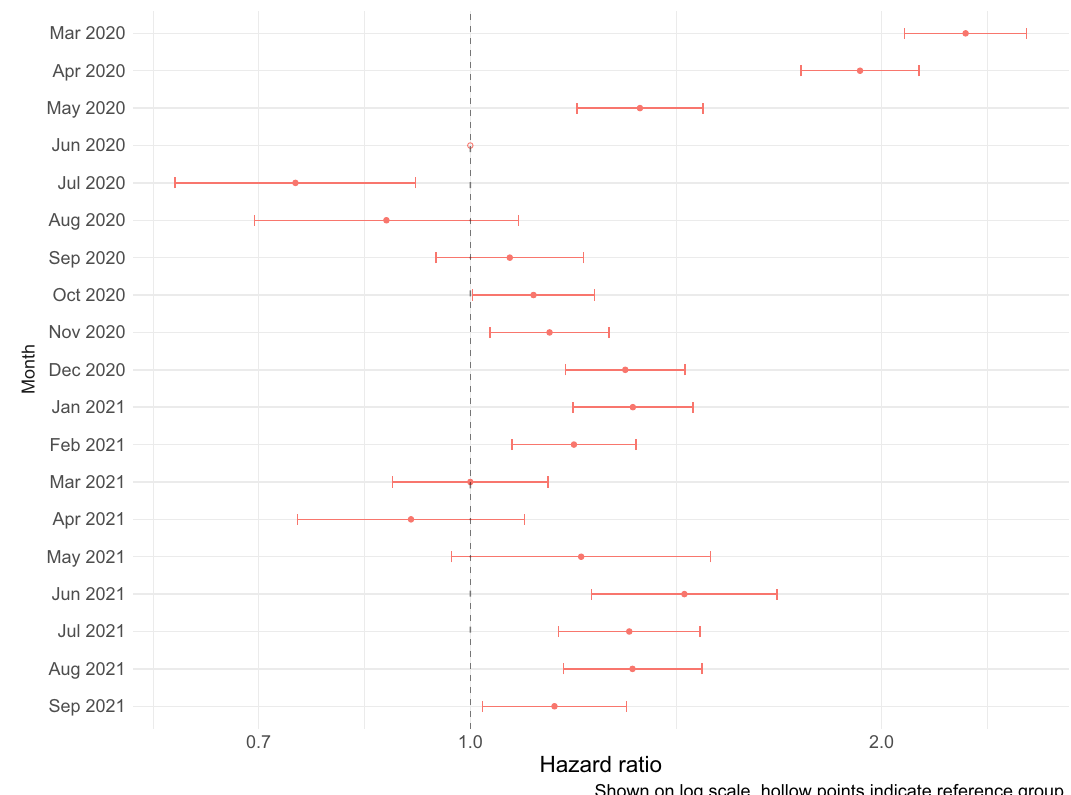
Fig.5|Hospitalisedfatalitysub-distributionhazardratiobymonthofhospital admission. March 2020 to September 2021. Model includes strati fi cation on age group, region of residence, and vaccination status, and regression adjustment (maineffects)onmonthofhospitaladmission,sex,ethnicity,IMDquintile,hospital